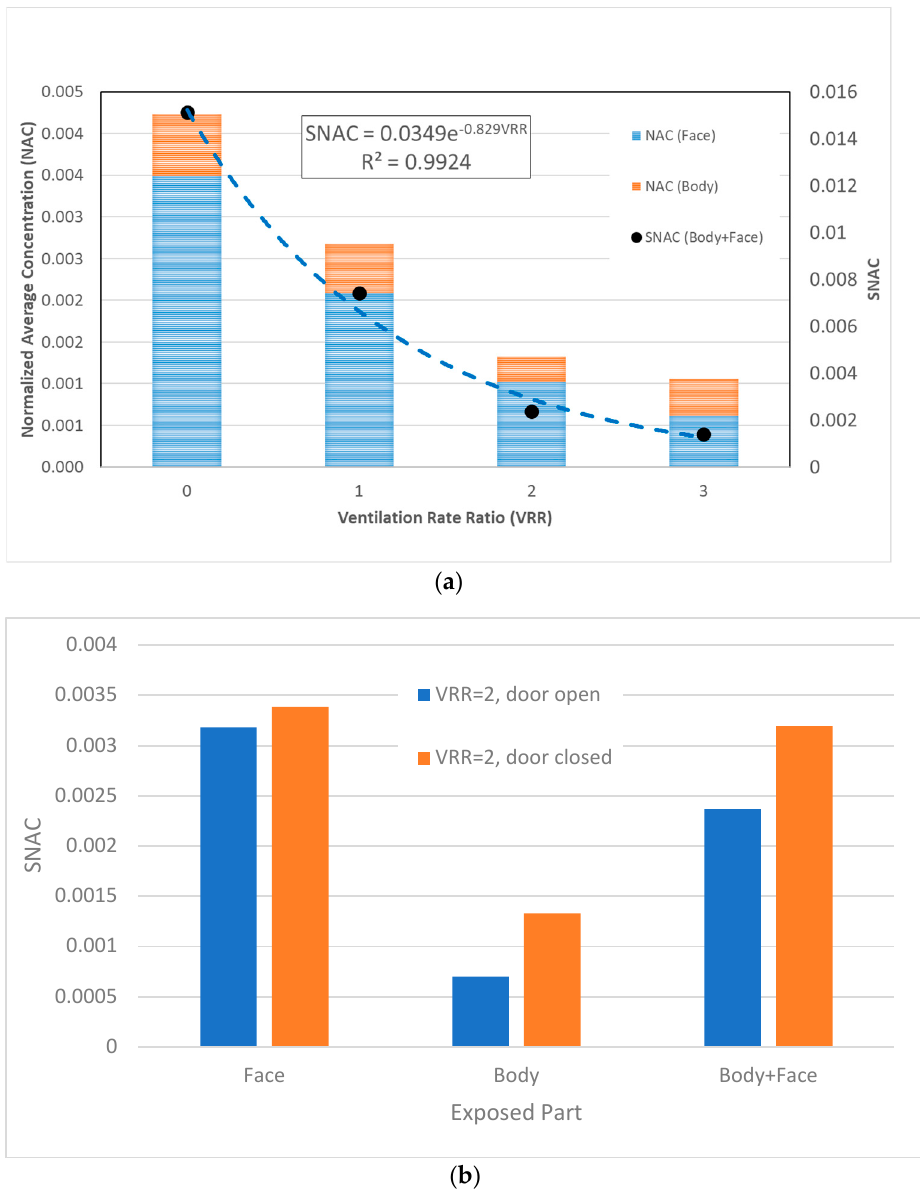
Figure 11. Variation of ( NAC ) and ( SNAC ) with the ventilation rate and gate status. ( a ) Variation of ( NAC ) and ( SNAC ) with the ventilation rate. ( b ) Variation of the total ( SNAC ) (body+face) with door status (open/closed).